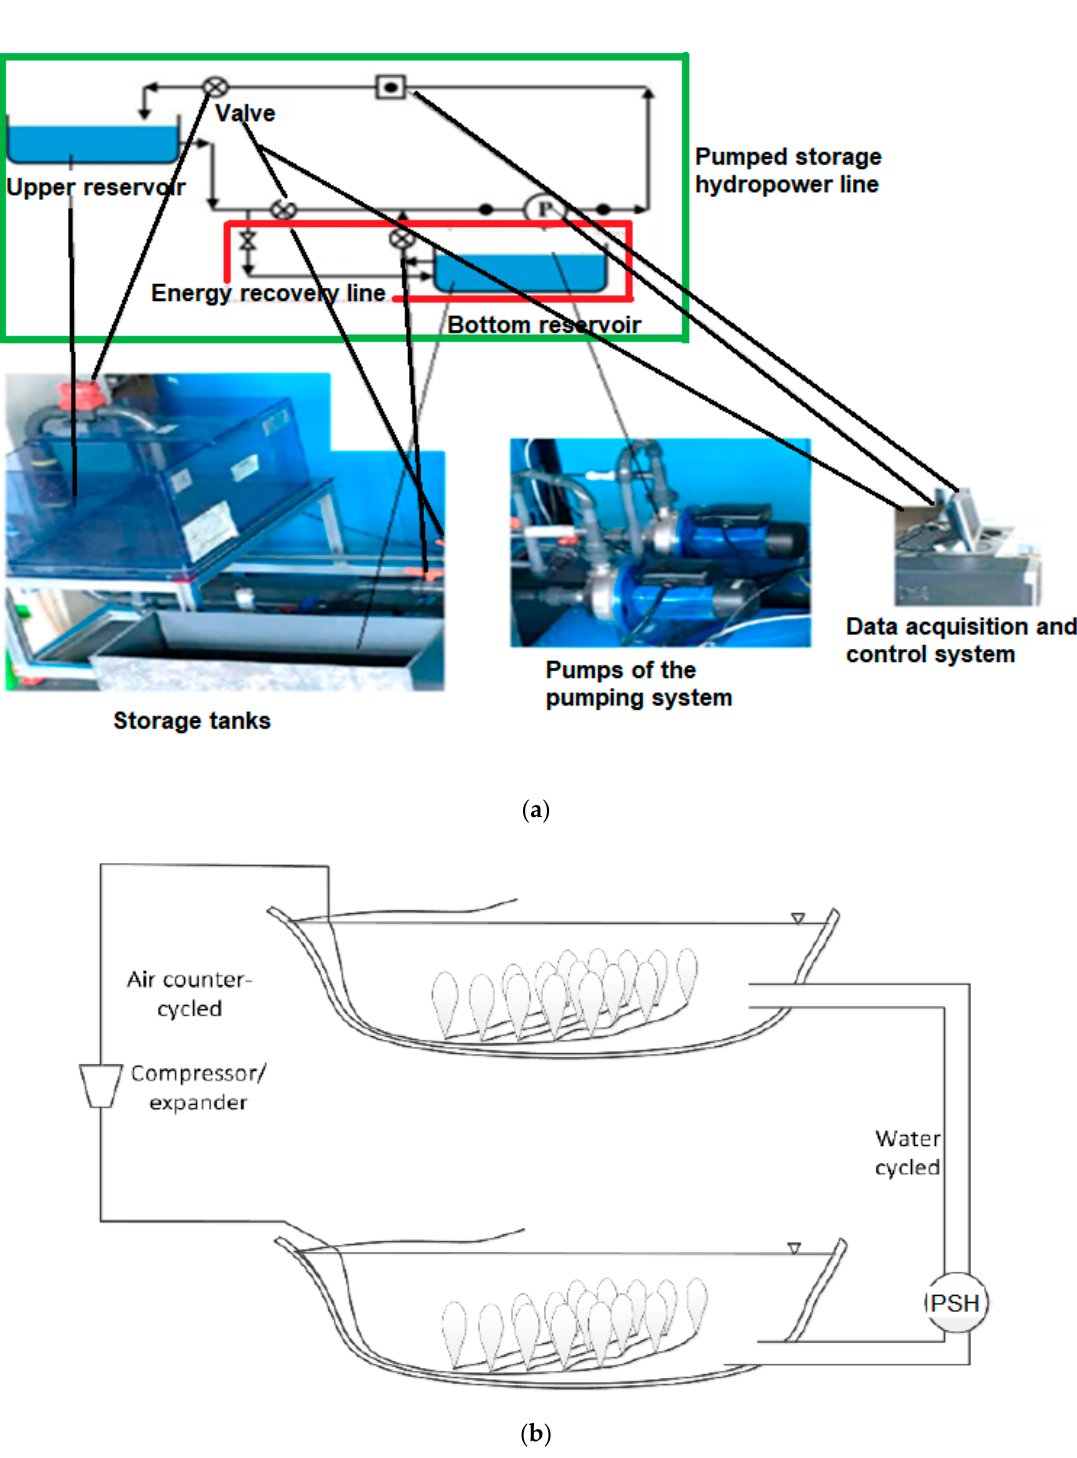
Figure 7. Pumped-storage hydropower integration in water systems ( a ) and with an Air Cushion Underground Cavern (ACUR) ( b ).